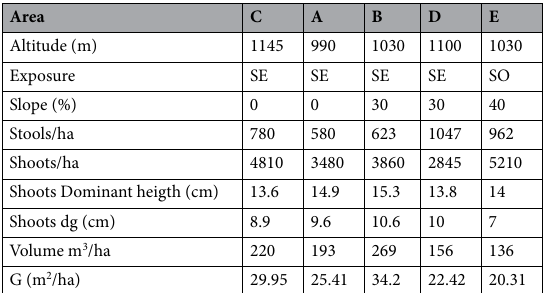
Table 1. Dendrometric parameters of chestnut studied stands on Amiata mountain (in 32 modified).